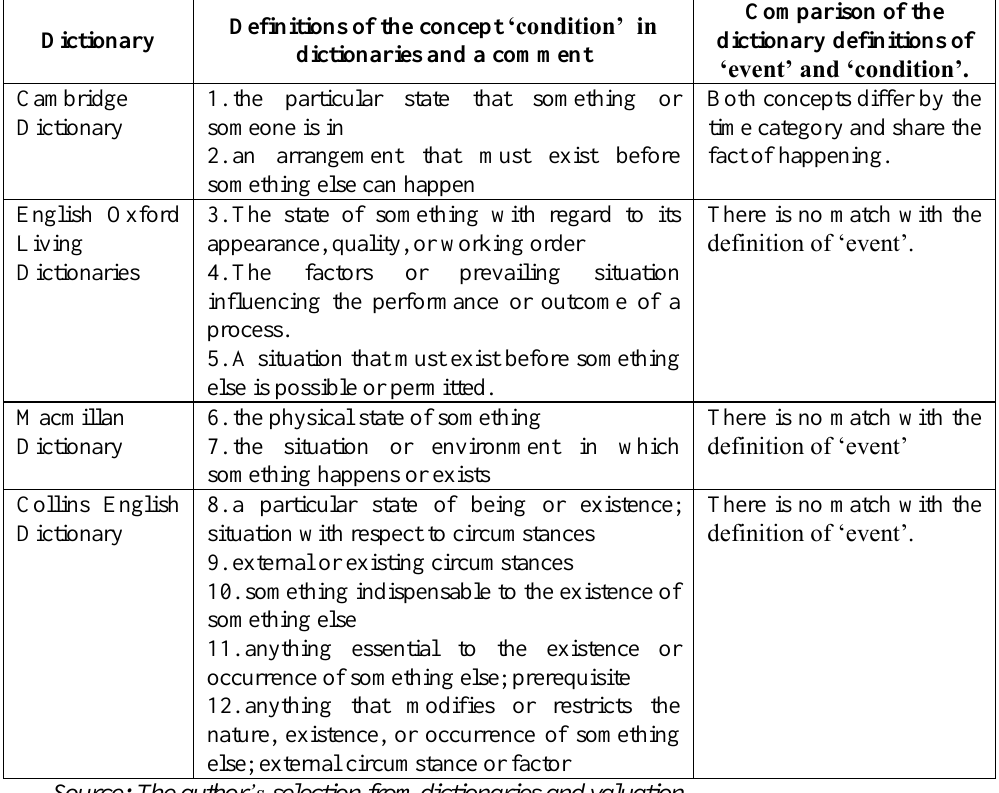
Table 8. Accordance with the definitions of ‘event’ and